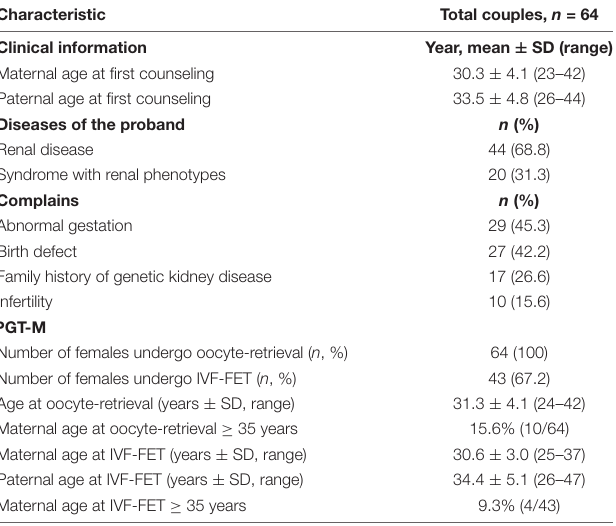
TABLE 1 | Baseline characteristics of preimplantation genetic testing for monogenic disease (PGT-M) couples in the genetic kidney diseases/syndromes with renal phenotypes cohort.